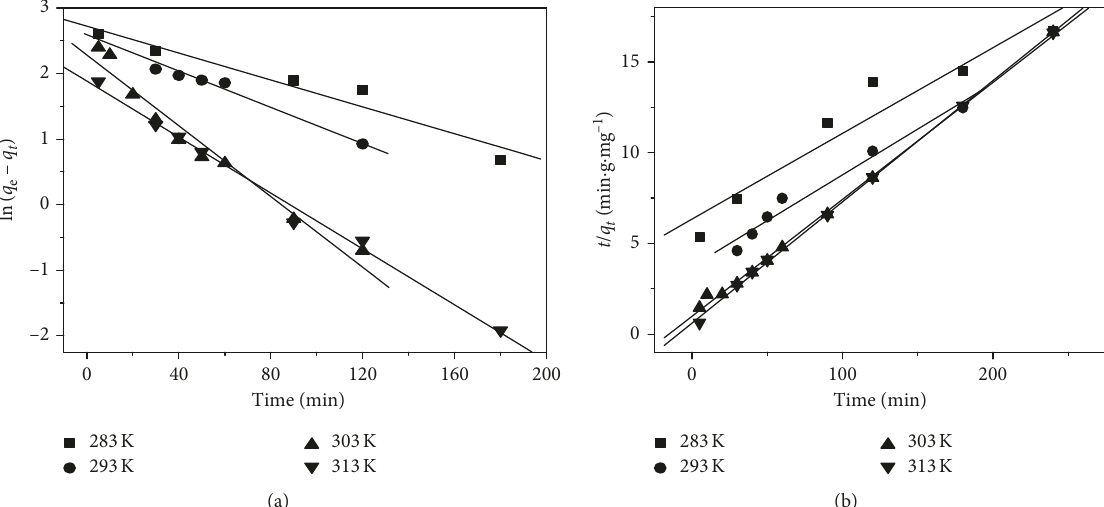
Figure 9: The pseudo-first-order kinetic model (a) and pseudo-second-order kinetic model (b) of As(V) adsorption by Fe-B at different